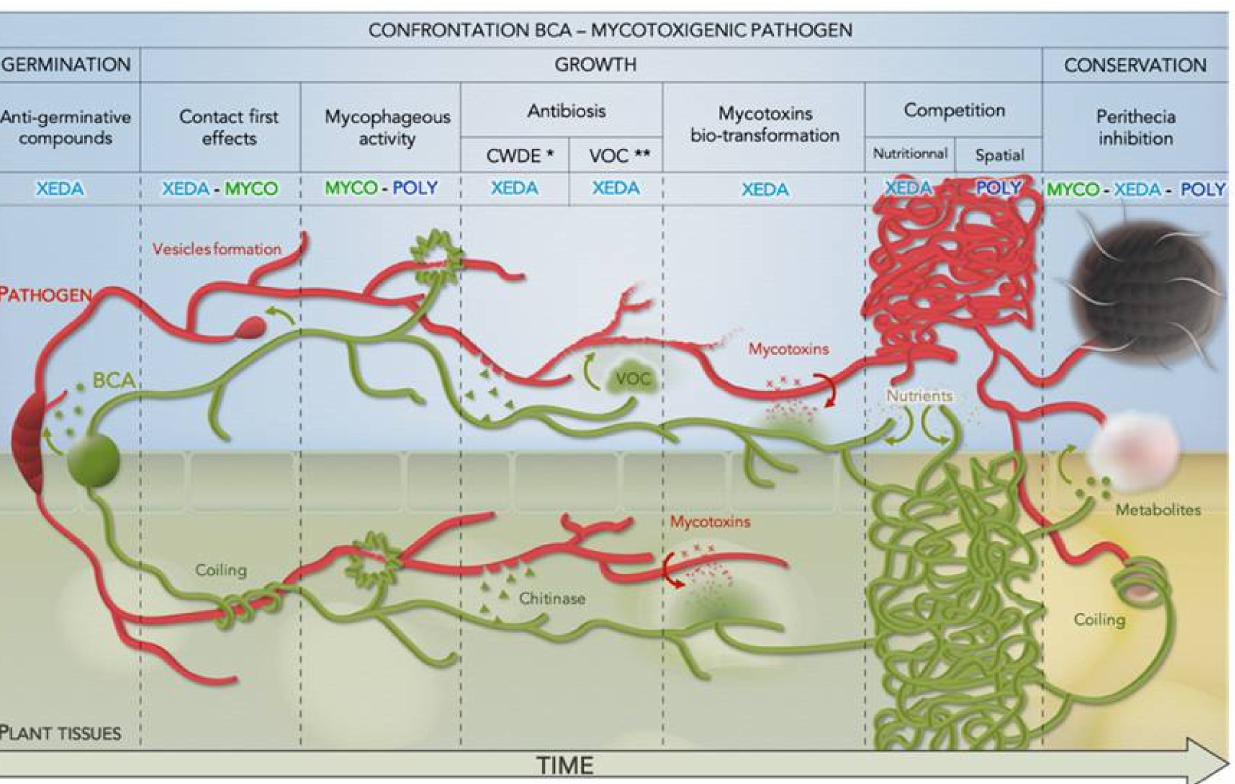
Figure 12. BCAs biocontrol mechanisms activity against pathogenic Fusarium over time. During confrontation between BCA and mycotoxigenic pathogen, a broad range of weapons can be used by BCAs, from the germination of pathogen, during growth phase, to conservation under perithecia structure. The best performing BCA(s) for each mechanism of action are noted as an indication in the third row of the figure. Depending on the BCAs considered, anti-germination compounds can be synthesized to inhibit the germination of pathogenic spores. The first contacts between microorganisms causes the formation of particular structures or deformations of pathogenic hyphae. BCAs can coil around the pathogenic mycelium and block their progression. Even in the absence of nutrients, they may be able to develop colonies around the active pathogen mycelium through mycophagous activities. BCAs, using a battery of secreted compounds such as cell wall degrading enzymes (*CWDEs) or antifungal volatile compounds (**VOCs), will limit the spread of the pathogen. BCAs are also able to directly degrade the mycotoxins produced or inhibit all or part of the biosynthesis pathway of these toxins in pathogens. Moreover, when the development of microorganisms is more advanced, competitions may occur. BCAs are able to attract the nutrients necessary for the growth of the pathogen, but also to colonize more space quickly to block the progression of the Fusarium. At the end of the life cycle of pathogens, BCAs can also prevent the formation of conservative structure, the perithecia, or interfere with them after they are